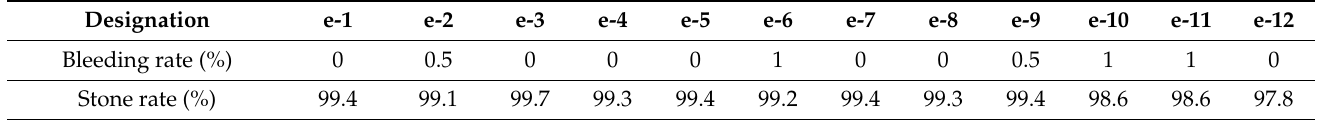
Table 6. Test results of bleeding rate and stone